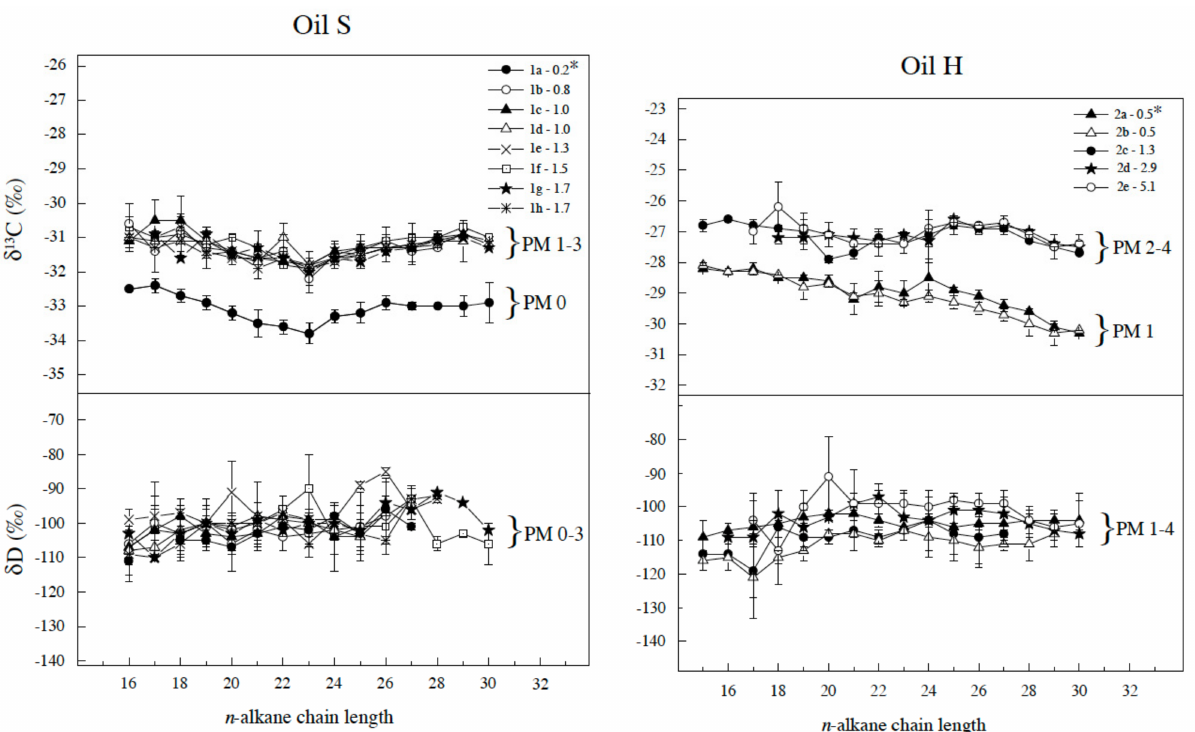
Figure 3. Carbon (based on V-PDB scale) and hydrogen (based on V-SMOW) isotopic composition of n -alkanes from Oils S and Oils H (Tables S2 and S3). * sample identification numbers and the ratio of pristane + phytane over n C 17 + n C 18 alkanes. The least biodegraded sample is characterized by the lowest (“lightest”) ratio. PM refers to biodegradation levels according to